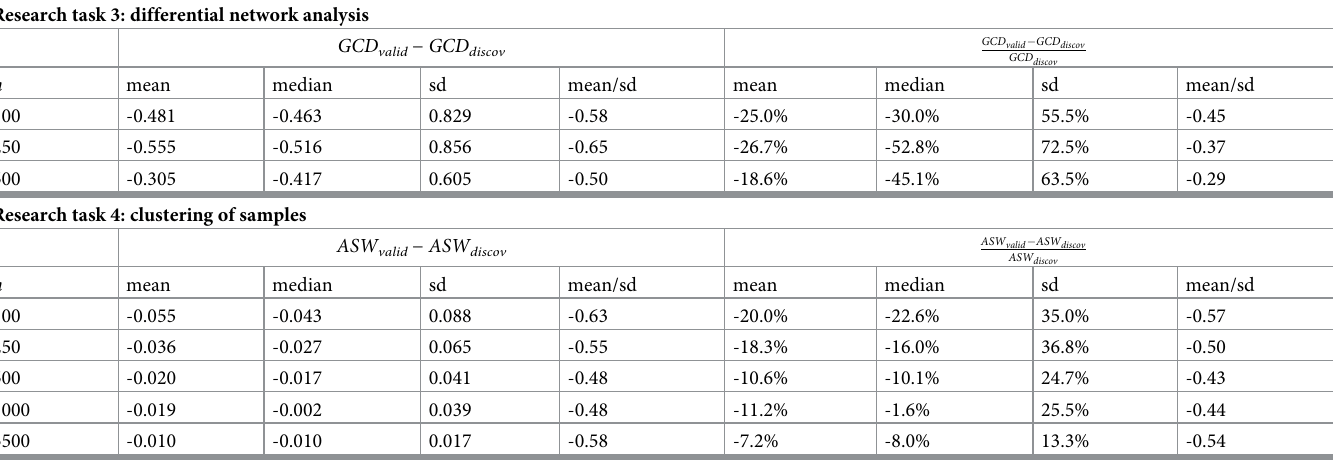
Table 2. For research tasks 3 and 4: Mean, median, and standard deviation (over 50 samplings of discovery/validation data) of the difference (both unscaled and scaled) between the value of the evaluation criterion on the validation data and the corresponding value on the discovery data. Additionally, the effect size (mean divided by standard deviation) is reported. GCD denotes the largest GCD on the discovery data and GCD the GCD resulting from the corresponding method com- discov valid bination on the validation data. The quantities ASW discov , ASW valid (average silhouette width) are defined